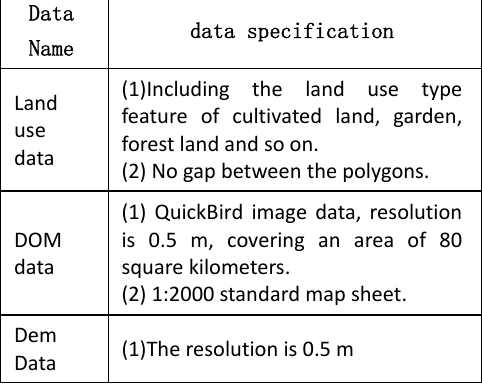
Table2: Experimental raw data summary